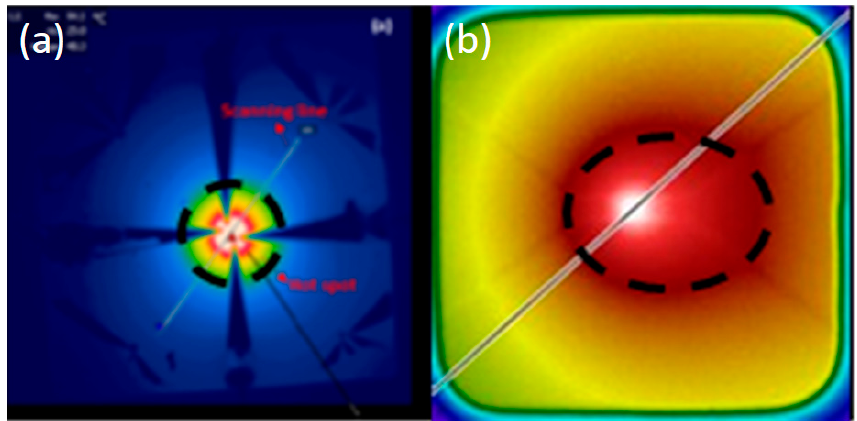
Figure 15. Cooling efficiency of the single-layer hBN heat spreader. Replotted data sourced from Reference [47].